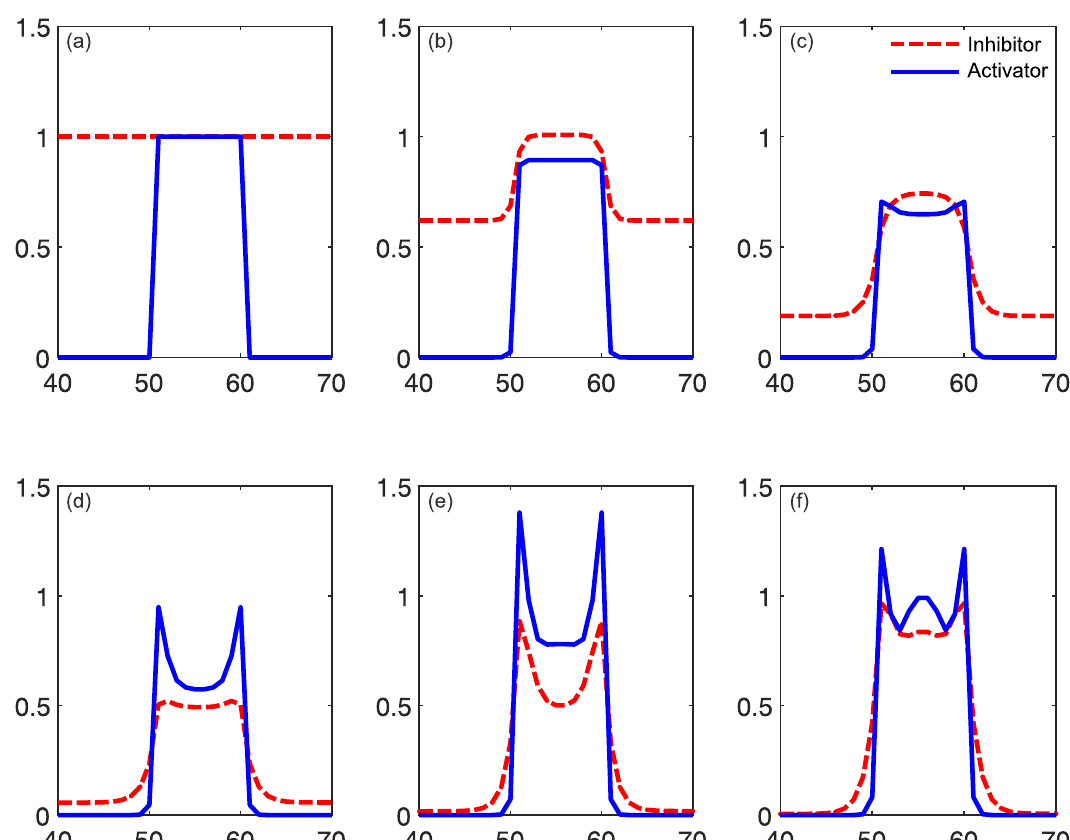
Figure 7. The reaction–diffusion model output for the initial conditions and the first few arbitrary simulated time stages. In this model, the diffusion rate of the inhibitor is twice that of the activator. ( a ) shows the initial conditions of the system, and the inhibitor is set to 1. The activator is initiated to zero, seeded with an area (“spike”) of activity due to random fluctuation. In this spike, the activator is set to 1. ( b ) The activator spike has enhanced the inhibitor in that area, so the inhibitor levels increase to greater than 1 (overshoot) in the region of the activator spike. The inhibitor in other areas is reduced, due to the decay rate. The inhibitor increase is slightly wider than the activator due to the different diffusion rates. ( c ) The effects of inhibition can be seen as the level of the activator reduces. ( d ) Inhibitor levels have fallen as there is less of the activator. The activator enhances both itself and the inhibitor, so at a certain point the levels of activator are low enough that the levels of inhibitor also drop. As the inhibitor has a faster diffusion rate than the activator, this means that the drop is faster for the inhibitor. As the inhibitor is reduced, the activator levels begin to rise again in response to the reduced inhibitor levels—note the edges of the peak, where the reduction in inhibitor is more pronounced and so the increase in activator is beginning to take shape. ( e ) The activator levels have risen in response to the reduced inhibitor levels, and this is more pronounced at the edges. Inhibitor levels start to rise again in response. ( f ) Levels of inhibitor rise again, completing the cycle, this time spatially extended from the original spike location. This continues to create a periodic pattern, under the right